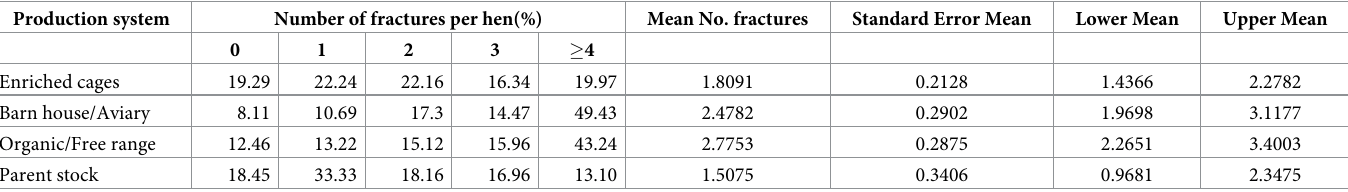
Table 8. Distribution of the number of fractures (%) in each hen within a production system (n = 4639 hens in 39 flocks). Production